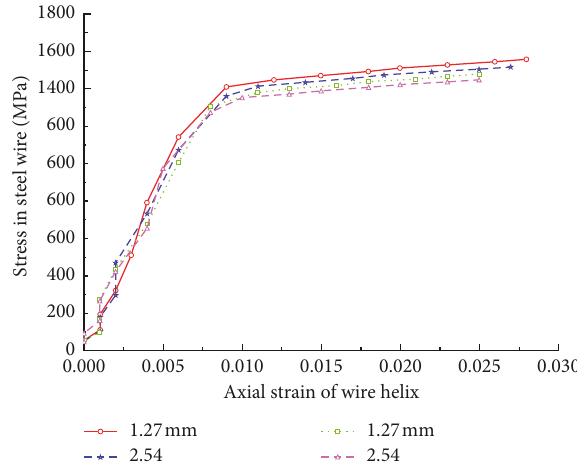
Figure 13: Influence of pitting corrosion length on mechanical properties of steel wire (condition